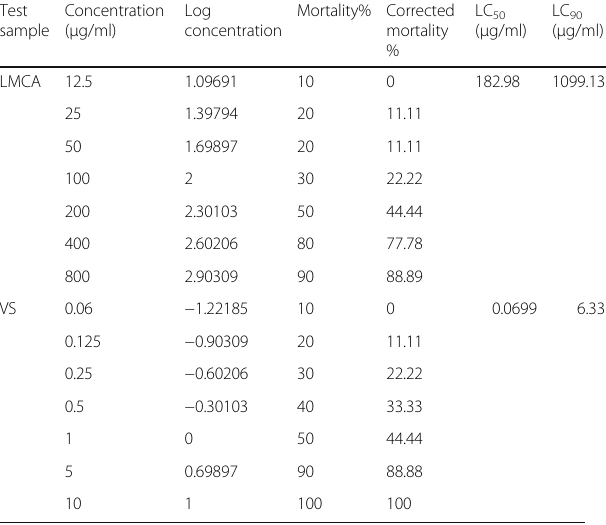
Table 2 Mortality % of Brine shrimp produced by LMCA along with the standard Vincristine sulphate Test Concentration sample ( μ